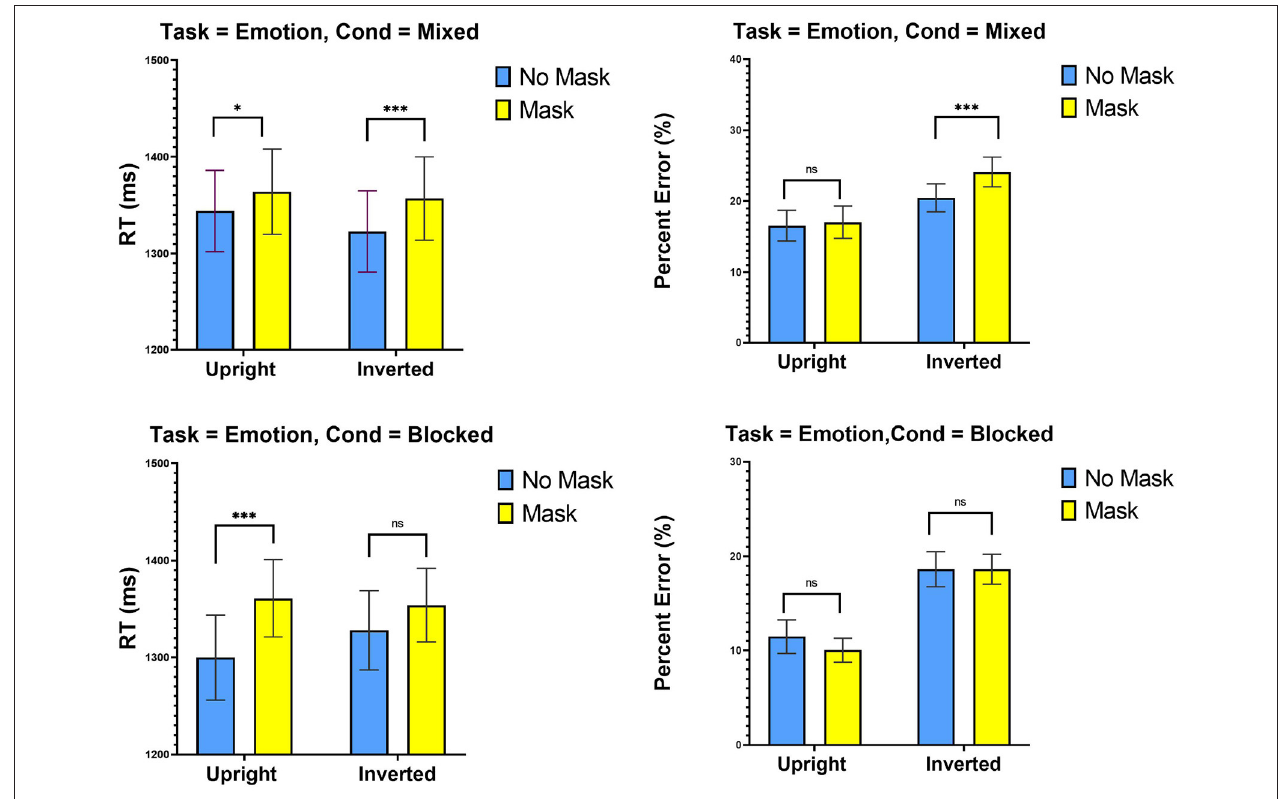
FIGURE 3 | Experiment 2: Mean RTs (ms) and percent error (%) as a function of mask (mask and no mask) and inversion (upright and inverted). Top panel: Mixed condition, bottom panel blocked condition. *** p < 0.001, ** p < 0.01, and * p < 0.05. Error bars are standard errors of the means.